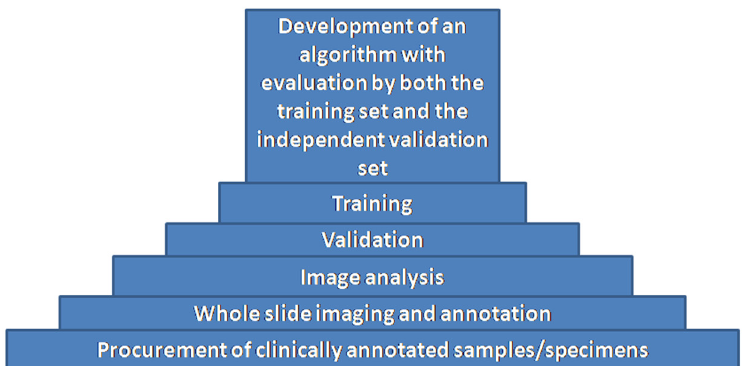
Figure 8. Algorithm Development (original diagram).